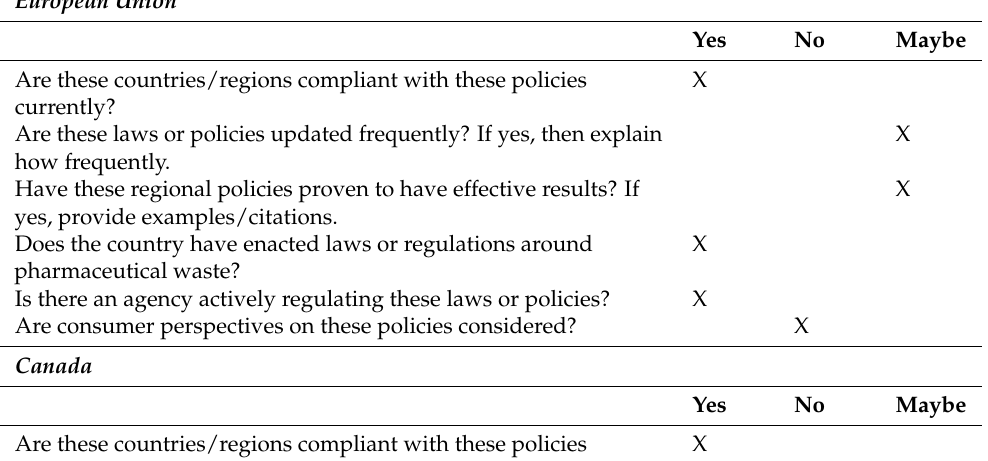
Table 3. Pharmaceutical Pollution Policy